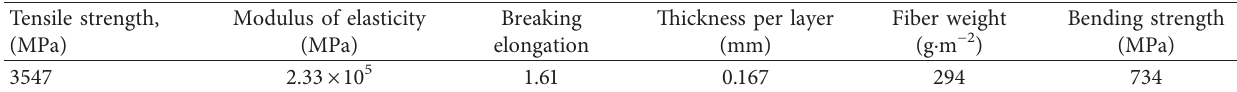
Table 3: Mechanical properties of CFRP.